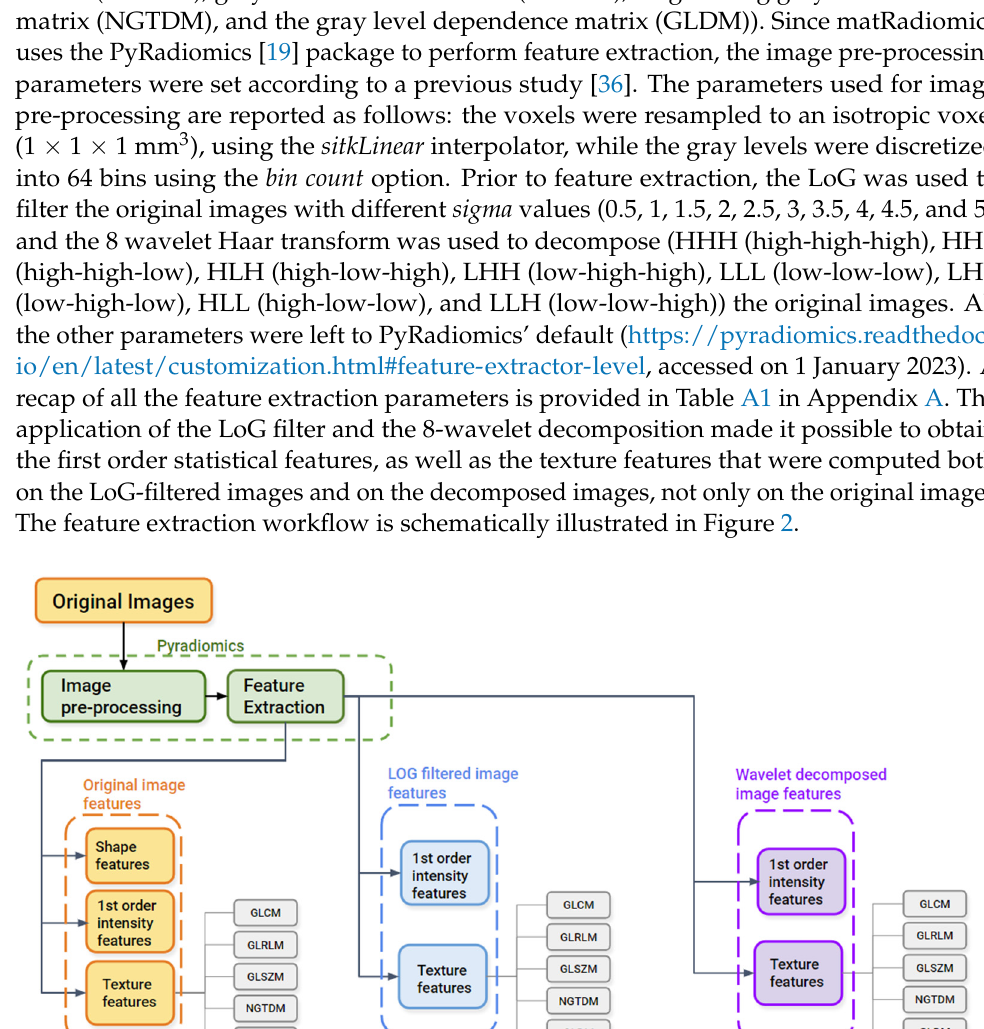
Figure 3. Final dataset subdivision into the 4-classes dataset, 3-classes dataset, and the 2-classes dataset. 2.3.4. Batch Analysis and Feature Harmonization Since CT images were obtained in three different centers (MAASTRO, Stanford, and VA) while using four different scanners, we investigated the presence of the batch effects. This analysis was preliminarily conducted on all the datasets (the 4-classes dataset, 3- classes dataset, and the 2-classes dataset) and results were used to know which classes to use in order to build the batch vector, which was further used to perform feature harmonization across all the datasets. Therefore, principal component analysis (PCA) was performed to project the data in a space of reduced dimensions. We further performed the visual inspection of the 2D plot, consisting of only the first and second principal components (PC1, PC2) in order to investigate the presence of clusters. Moreover, we used